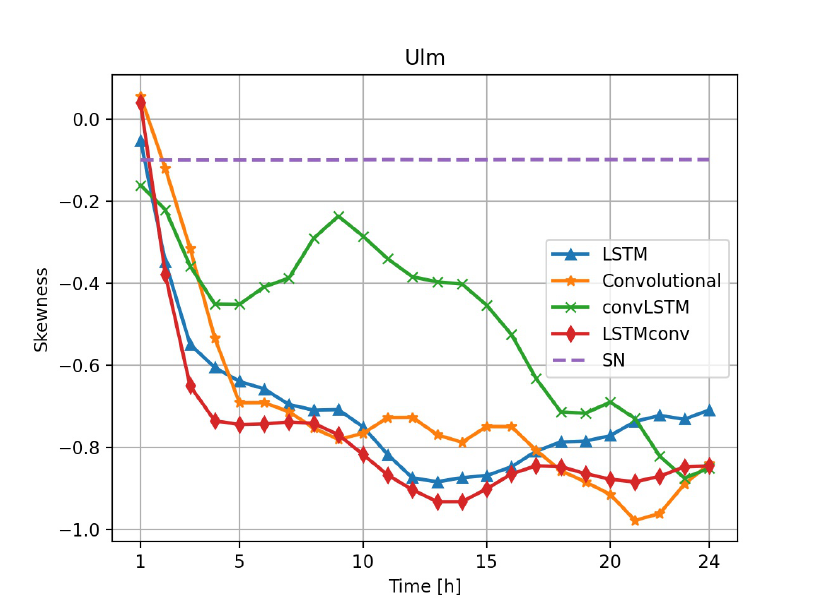
Figure 6. Skewness of the different NN models.